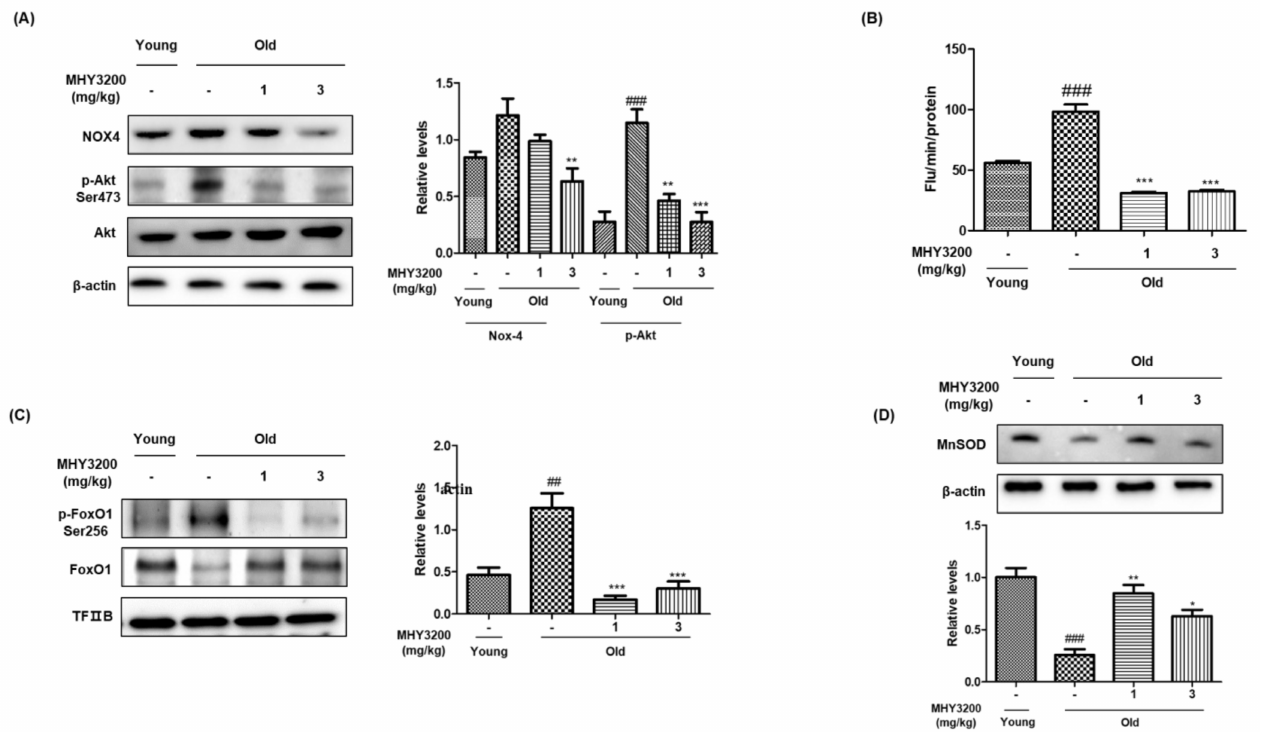
Figure 2. Effect of MHY3200 on NOX4/Akt signaling during the aging process. ( A ) Western blot analysis was performed to detect NOX4, phosphorylated Akt, and total-Akt in cytoplasmic extracts from kidneys. ( B ) ROS production was measured in the kidneys of young and aged rats using DCFH-DA assay. ( C ) Western blot analysis was performed to detect the phosphorylation of FoxO1 serine256 residue and total FoxO1 in the nuclear fraction. ( D ) Levels of MnSOD protein in the cytoplasmic extracts from rat kidneys. TFIIB and β -actin were used as nuclear and cytosolic internal controls and graphs were quantified with CS analyzer image analysis software. One representative blot is shown from three independent experiments in each group that yielded similar results ( n = 6). One-way analysis of variance (ANOVA) was used to determine the statistical result: ## p < 0.01, ### p < 0.001 vs. Young rats; * p < 0.05, ** p < 0.01, *** p < 0.001 vs. Old rats. Young (-), non-treated young rats; Old (-), non-treated old rats; 1, MHY3200 (1mg/kg)-treated old rats; 3, MHY3200 (3mg/kg)-treated old